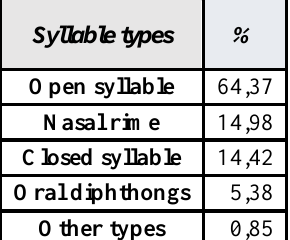
Source: Percentages were calculated based on the data presented by Vigário, Martins & Frota (2006: 681). “Closed syllables” includes both heavy syllables (ending in a rhotic) and light syllables (ending in extrametrical /S/), since no distinction was made by the authors; “Oral diphthongs” includes diphthongs followed by the plural morpheme /S/; “Nasal rime” includes nasal vowels and diphthongs followed by the plural morpheme